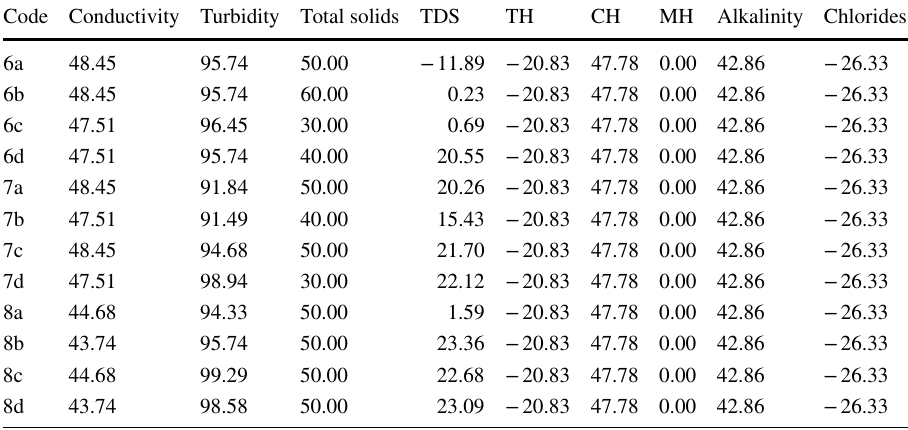
TDS total dissolved solids, TH total hardness, MH